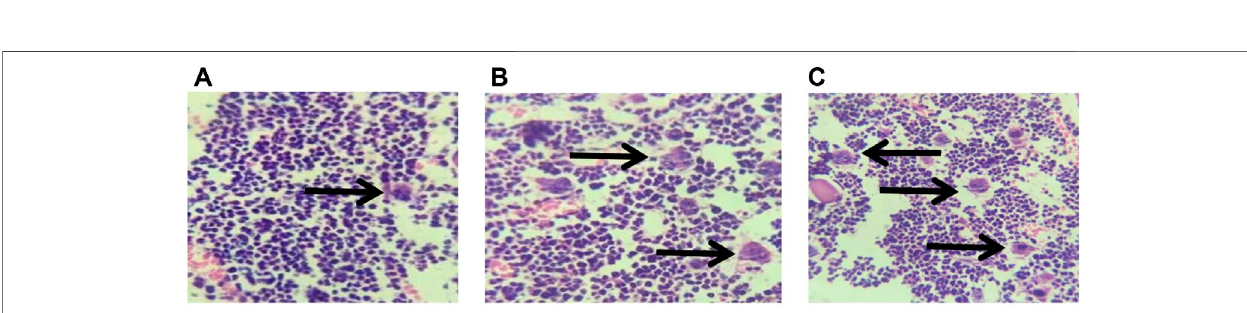
Frontiers in Environmental Science |